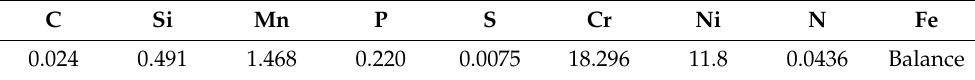
Table 1. Chemical composition in